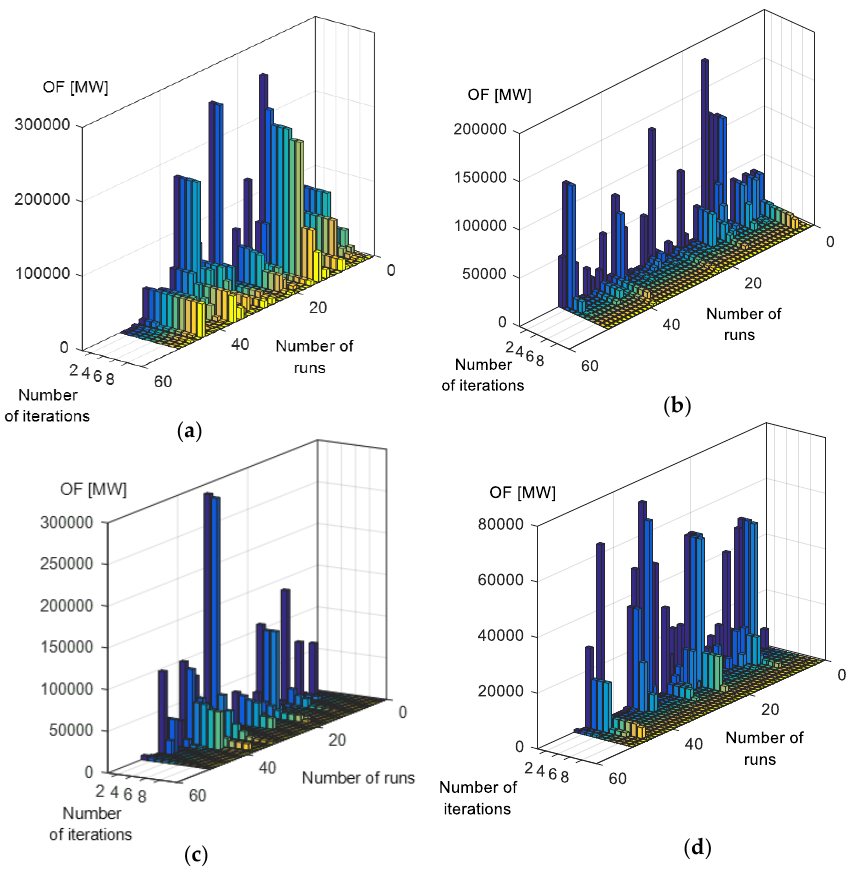
Figure 3. Change of OF during the first 10 iterations in multiple runs for the IEEE 30 test bus system: ( a ) PSO, ( b ) GSA, ( c ) ABC, and ( d ) DE